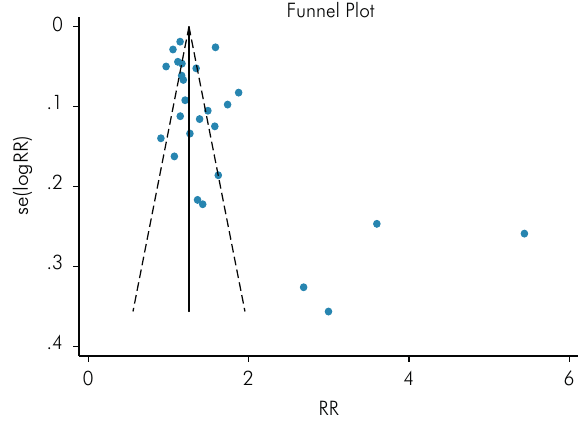
Figure 5. Funnel plot to investigate publication